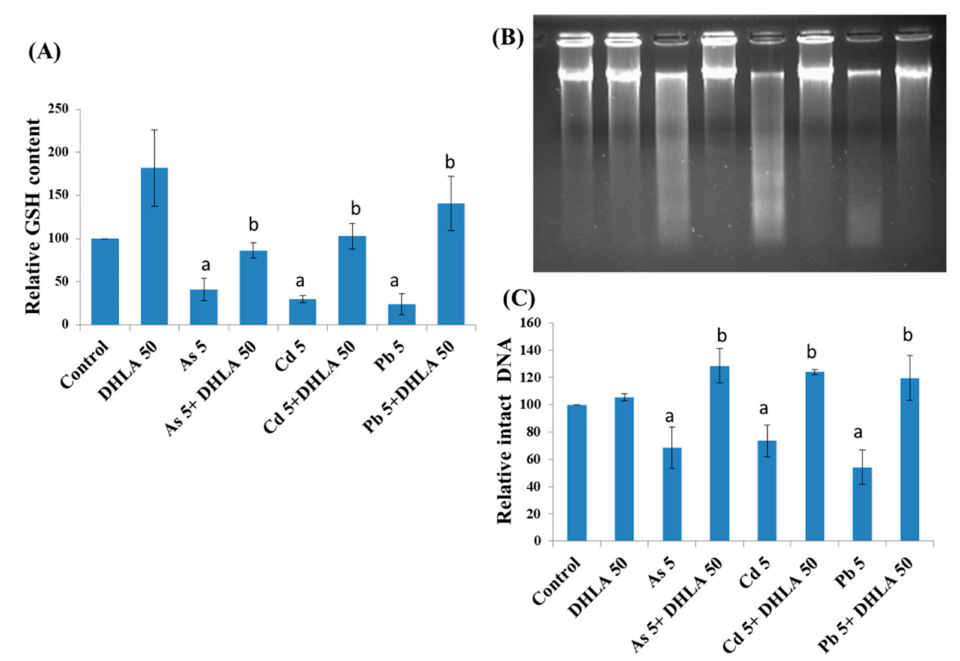
Figure 8. ( A ) Intracellular levels of GSH upon exposure to toxic metals and/or DHLA measured by the DTNB assay in PC12 cells. ( B ) DNA electrophoresis taken by agarose gel method and ( C ) DNA density measurement calculated by image J software after co-treatment with metals and DHLA in PC12 cells. The values of the bars indicate the mean ± SEM ( n = 3 and n = 4, respectively). Here, “a” denotes a significant difference compared to the control group ( p < 0.05), and “b” denotes a significant difference compared to the associated metal group ( p <